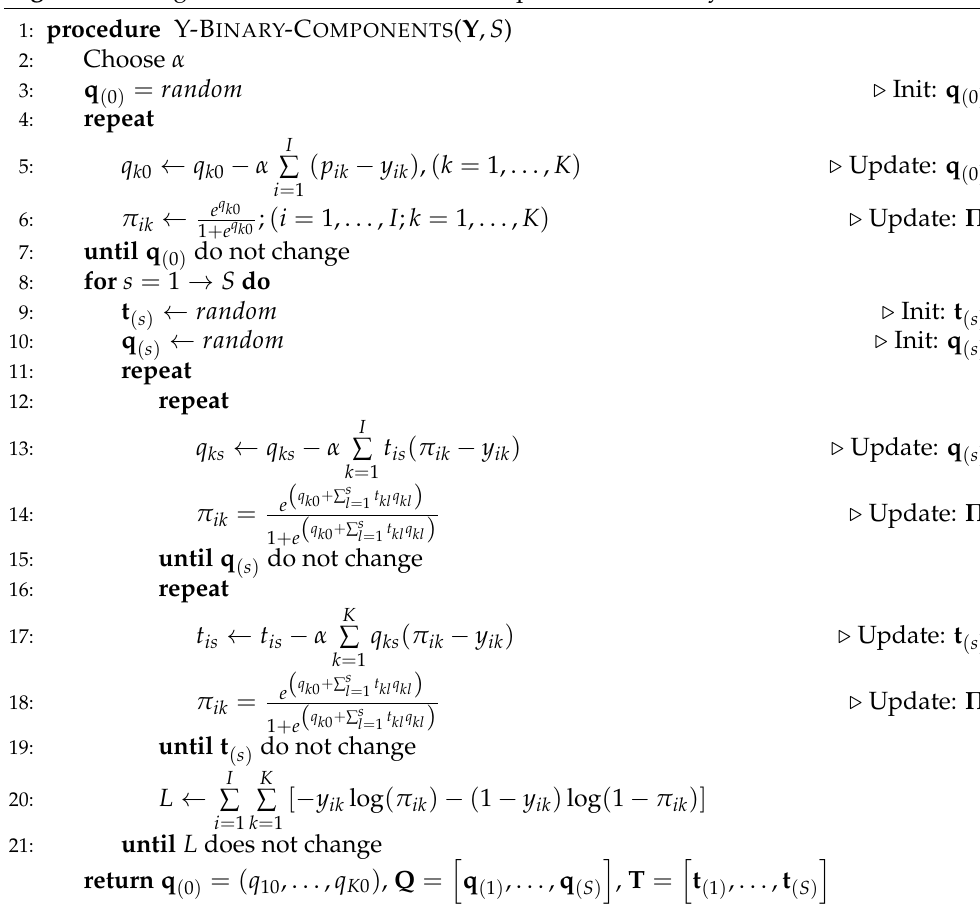
Algorithm 3 Algorithm to calculate the Y-Components for Binary